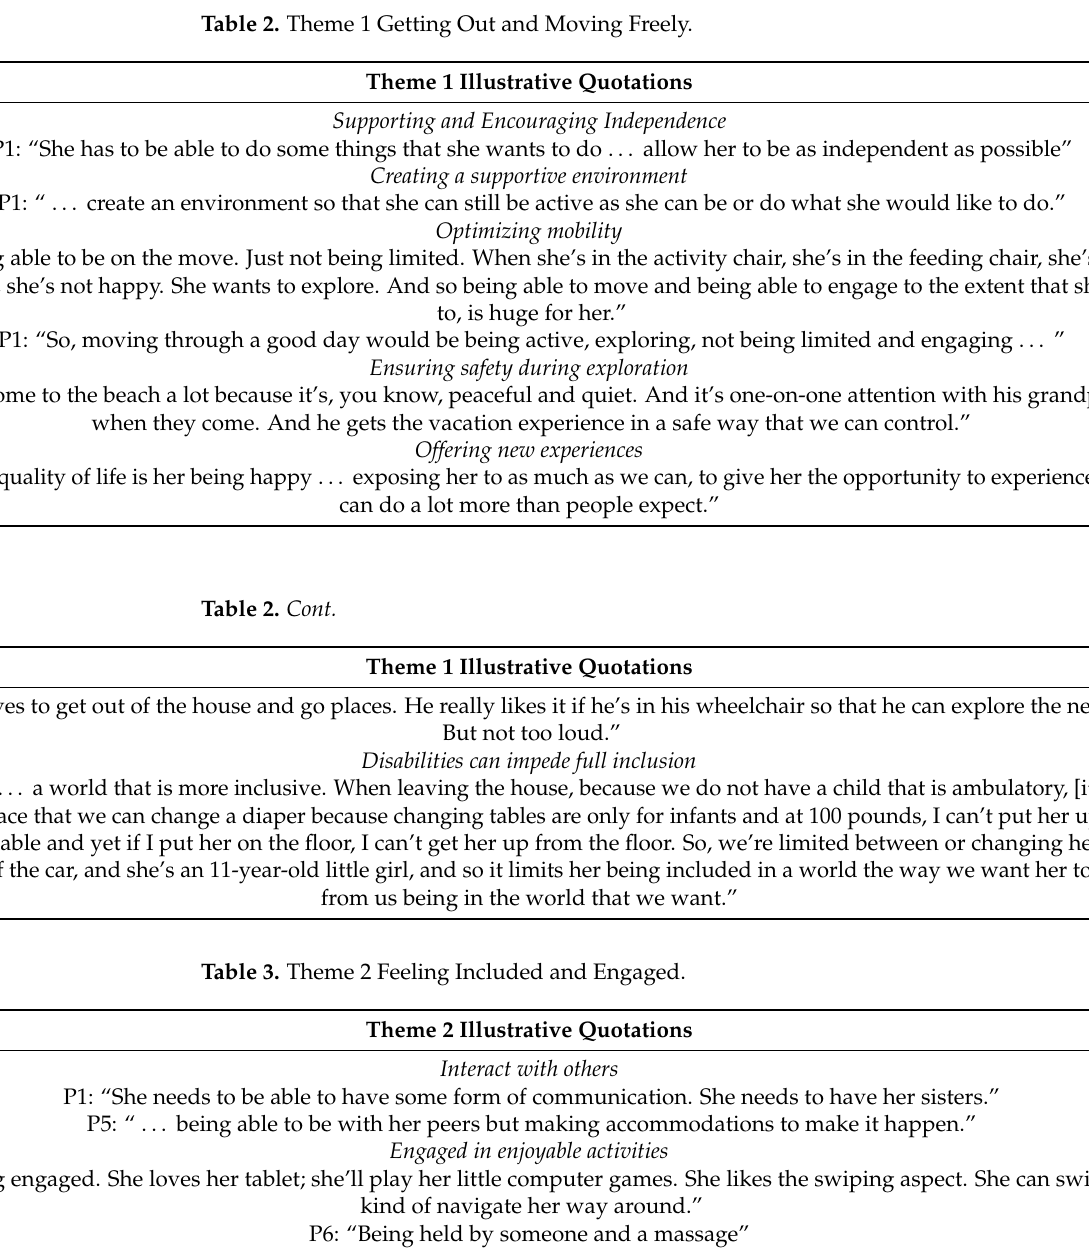
Table 2. Theme 1 Getting Out and Moving Freely.